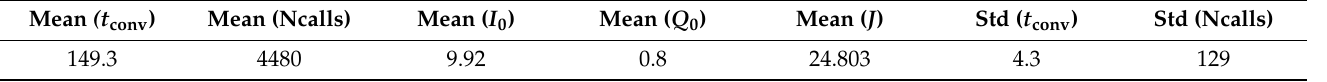
Table 4. Description of the objective